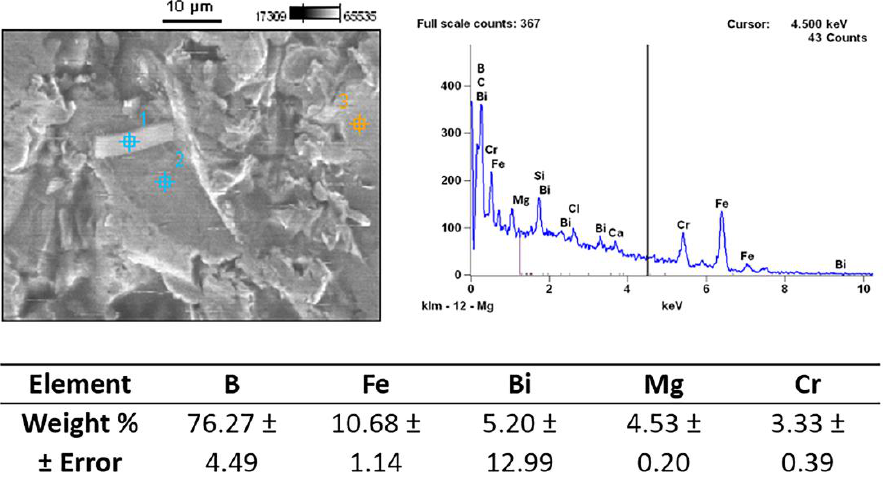
Figure 7. Scanning electron micrographs of lattice structure following sandblasting (experiment 1A). ( A ) Cavities at the joints. ( B ) Cavity free upper surface of joint. ( C ) Peel-off layer. ( D ) Residual irregular particles from the sandblasting process.